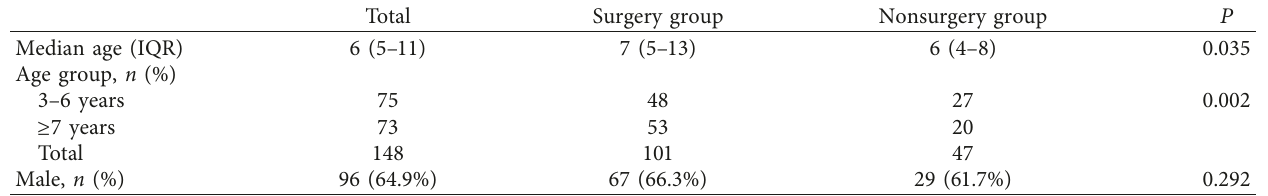
Table 1: The demographic characteristics of the included CEL patients.